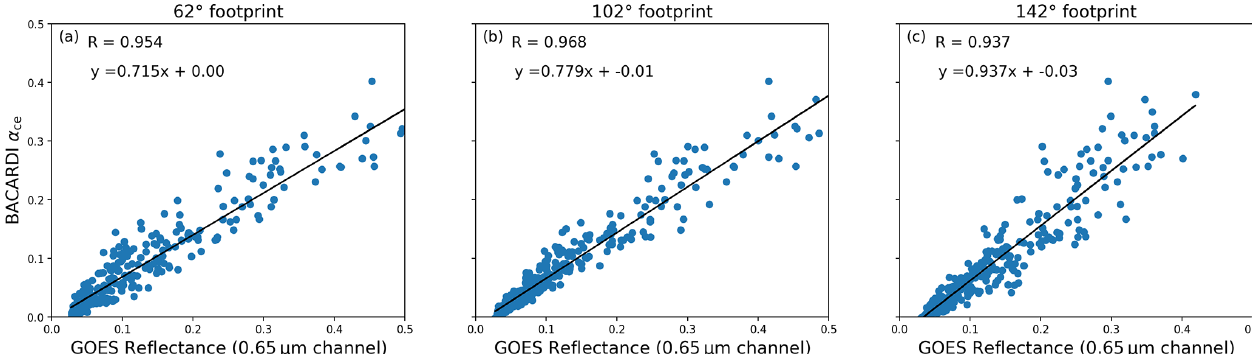
Figure A1. Comparison of α ce from BACARDI and the mean reflectance from the 0.65µm channel of GOES-16 for a FOV of (a) 62 ◦ , (b) 102 ◦ and (c) 142 ◦ from the flight on 24 January 2020. The data used here correspond to the location of the circle flight pattern given in Sect. 2.1 at a typical flight altitude of approximately 10km. The exact measurement times can be found in Table